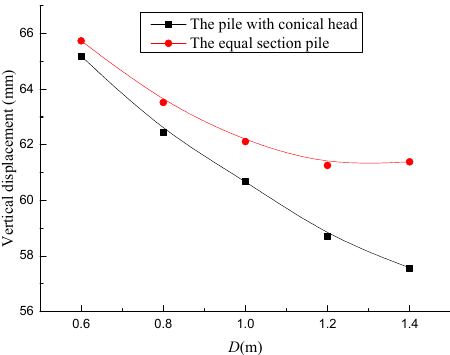
Figure 10. The vertical displacement of embankment surface vs. D.